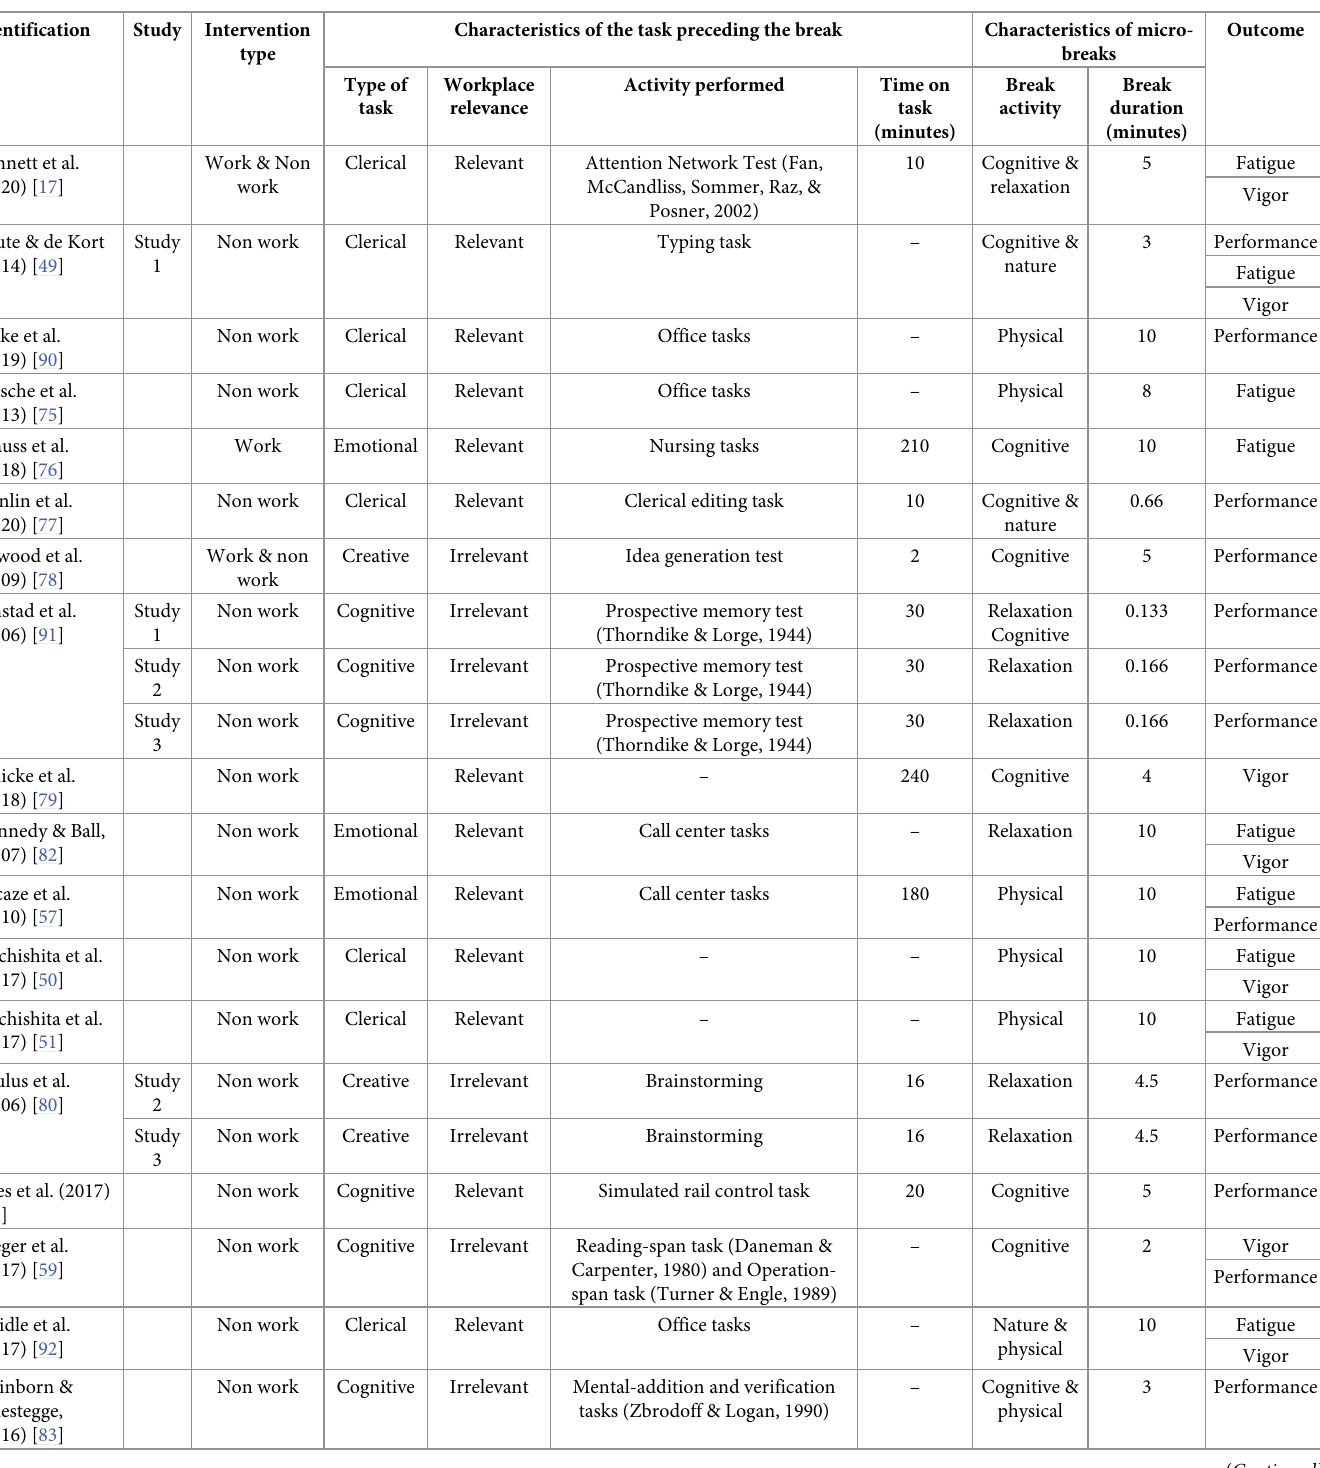
Table 2. Characteristics of the interventions and